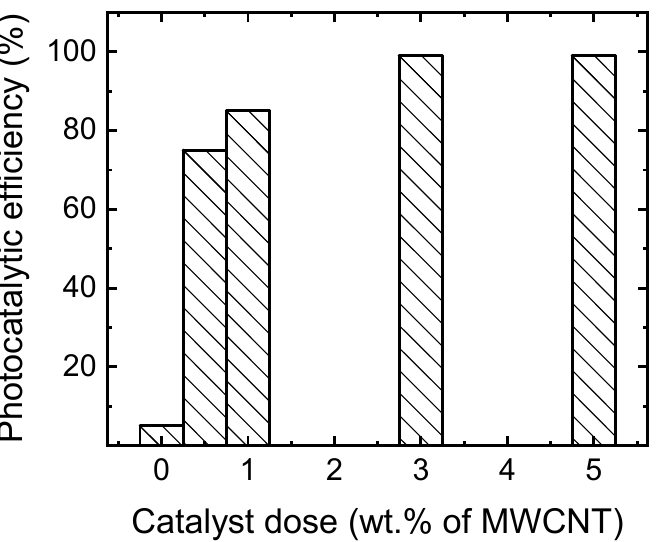
Figure 3. Effect of catalyst dose on the photocatalytic efficiency of Cr(VI) using the MWCNTs- Fe 3 O 4 @PES CNM.